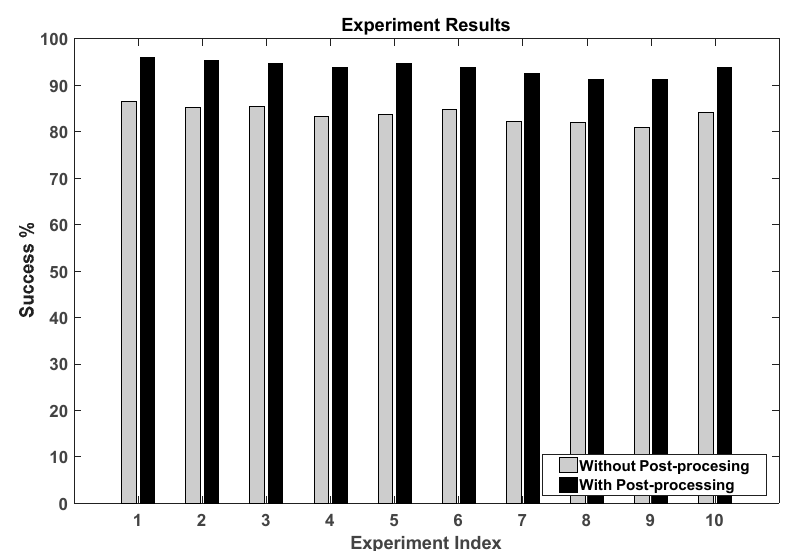
Figure 9. Comparison between the experimental results with and without post-processing. Table 3. Summary of experimental results.